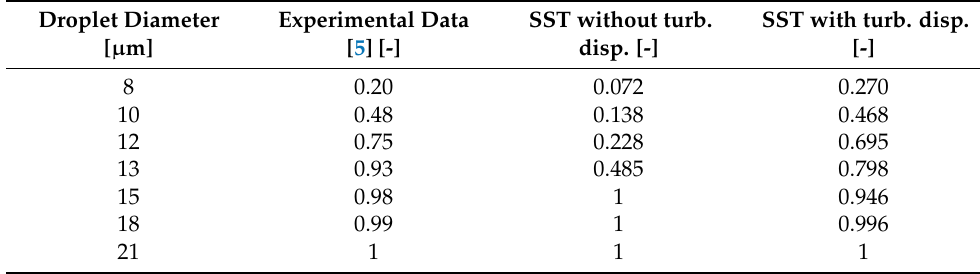
Table 6. Comparison of calculated results obtained with SST model with and without using turbulent dispersion with experimental data for geometry B_10_0 with inlet velocity 2 m s − 1 .